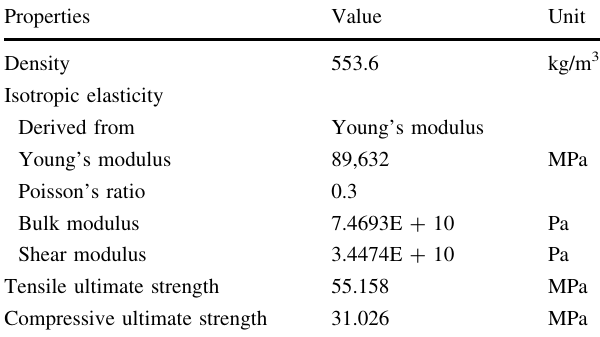
Table 1 Material properties of a southern yellow pine